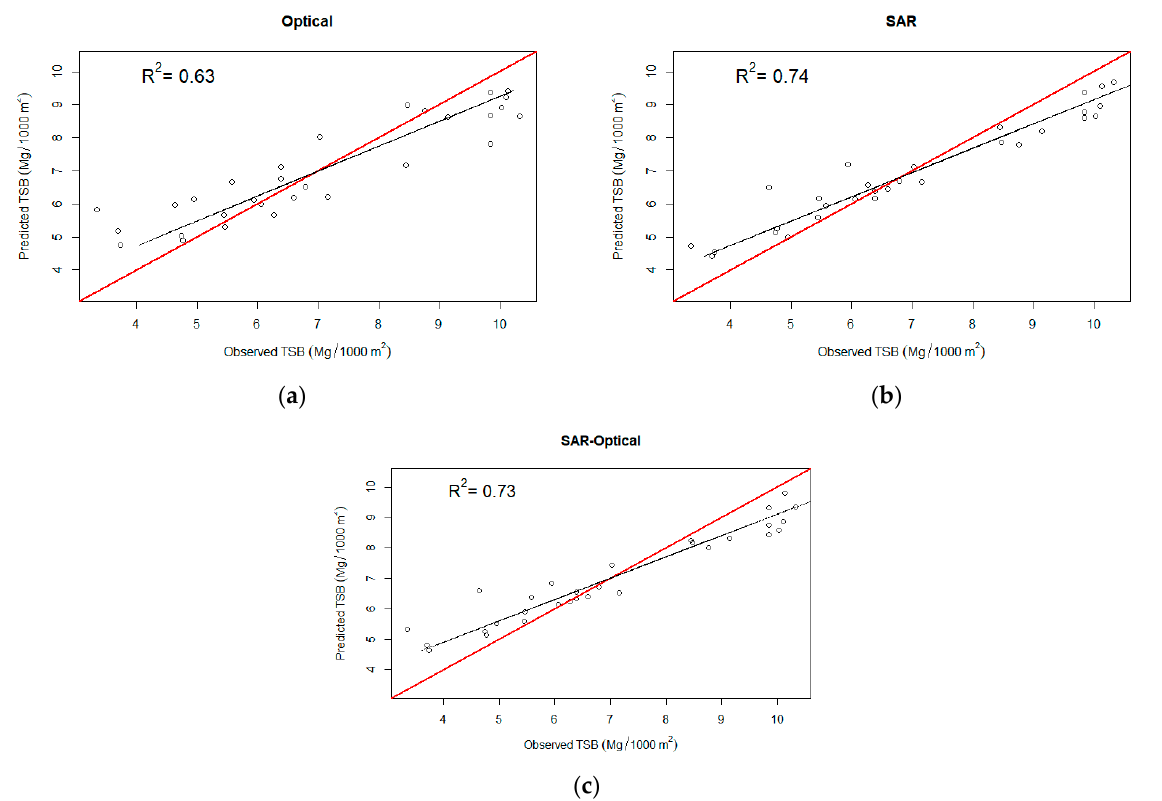
Figure 5. Predicted vs. measured biomass graph for the developed ( a ) optical, ( b ) SAR, and ( c ) SAR– optical predictive models for total stem biomass (TSB) estimation. The black line represents the fitted line, and the red line represents the 1:1 line.